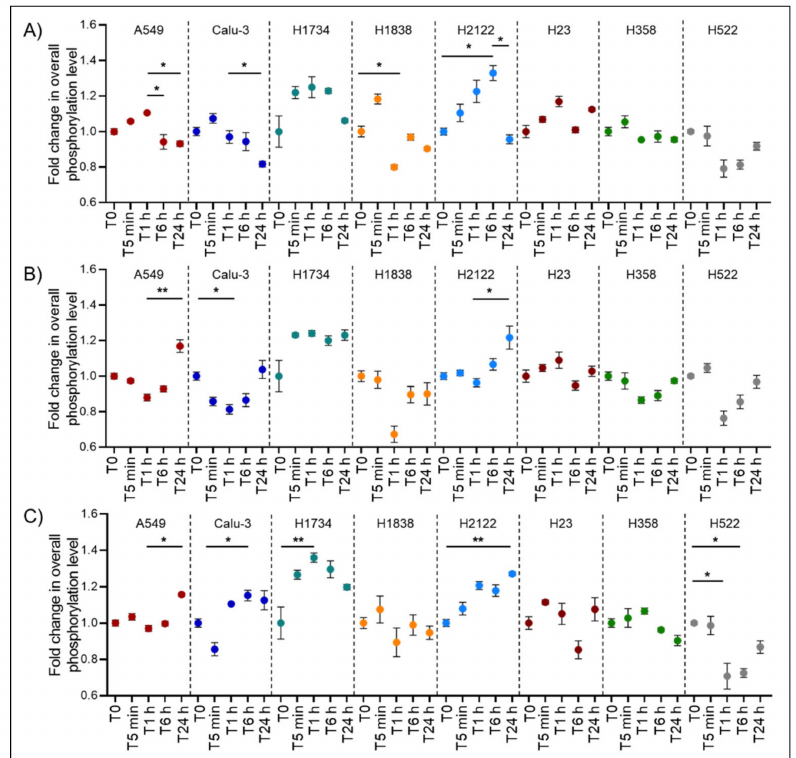
Figure 1. Dimethyl sulfoxide (DMSO) time- and dose-dependent changes of overall phosphorylation levels in eight lung cancer in vitro models. Broad change in protein phosphorylation levels was measured as aggregate changes of the Reverse Phase Protein Array (RPPA) intensity values across 125 post-translationally modified kinases and downstream substrates within each cell line. Tallied values for each cell line were normalized to the baseline (T0) of the corresponding DMSO concentration and expressed as fold change of the untreated values (C1 Panel A , C2 Panel B , and C3 Panel C , respectively). For each timepoint and DMSO concentration, technical replicates were collected ( n = 3) and mean and standard error of the mean are shown. Adjusted pair-wise comparisons that retained statistical significance (* p < 0.05; ** p < 0.01, respectively) are shown for each cell